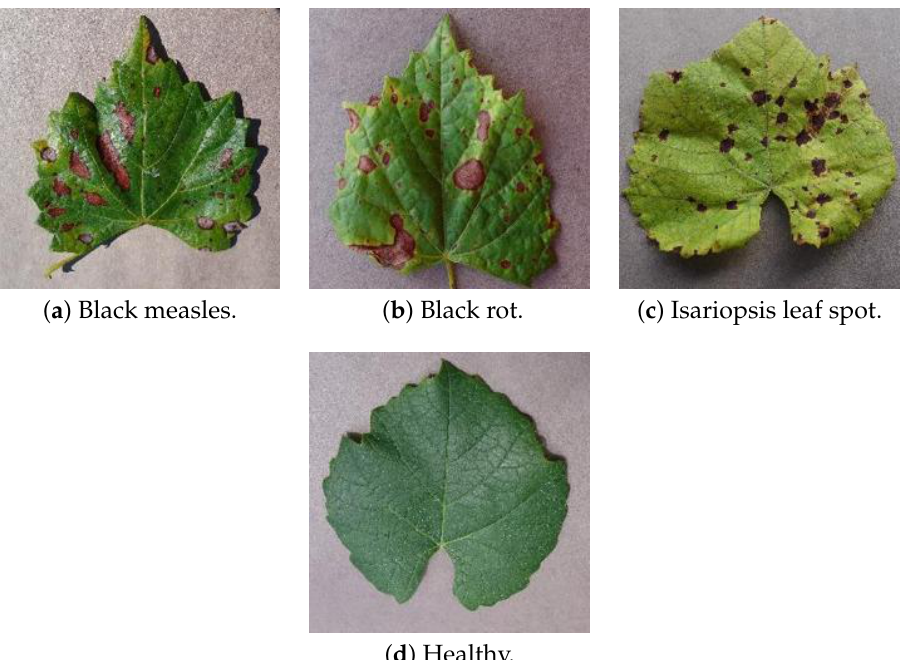
Figure 1. Examples from the dataset representing the four